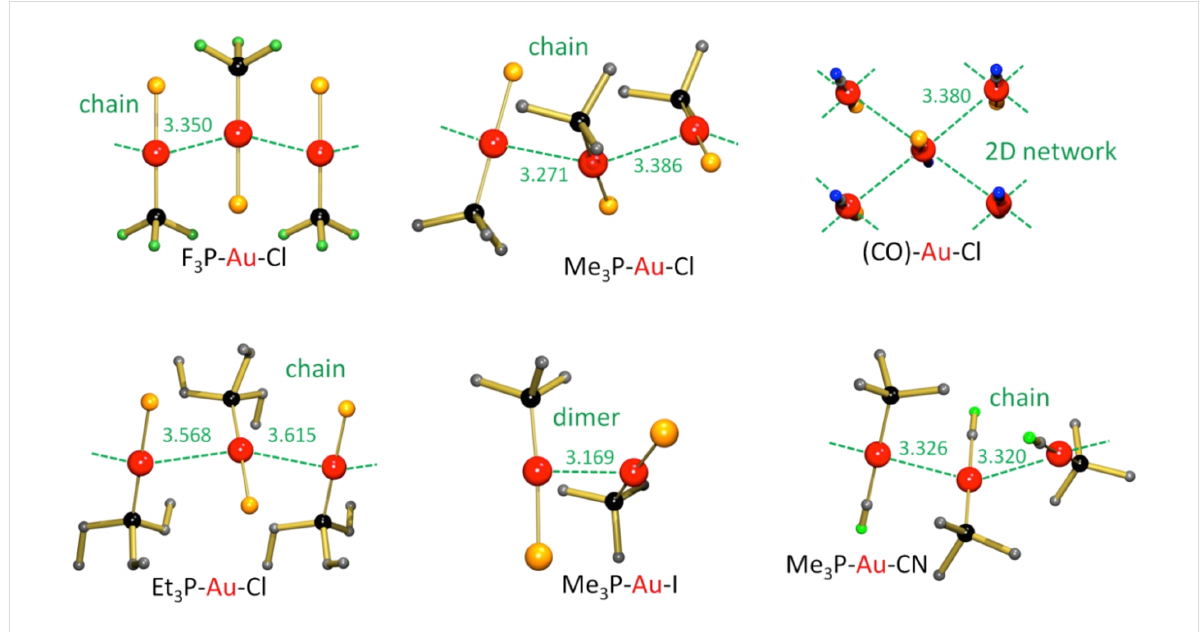
Figure 4: Crystal structures with aurophilic interactions. The green dashed lines indicate the Au–Au interactions, distances are given in angstroms. (a) ClAuPF